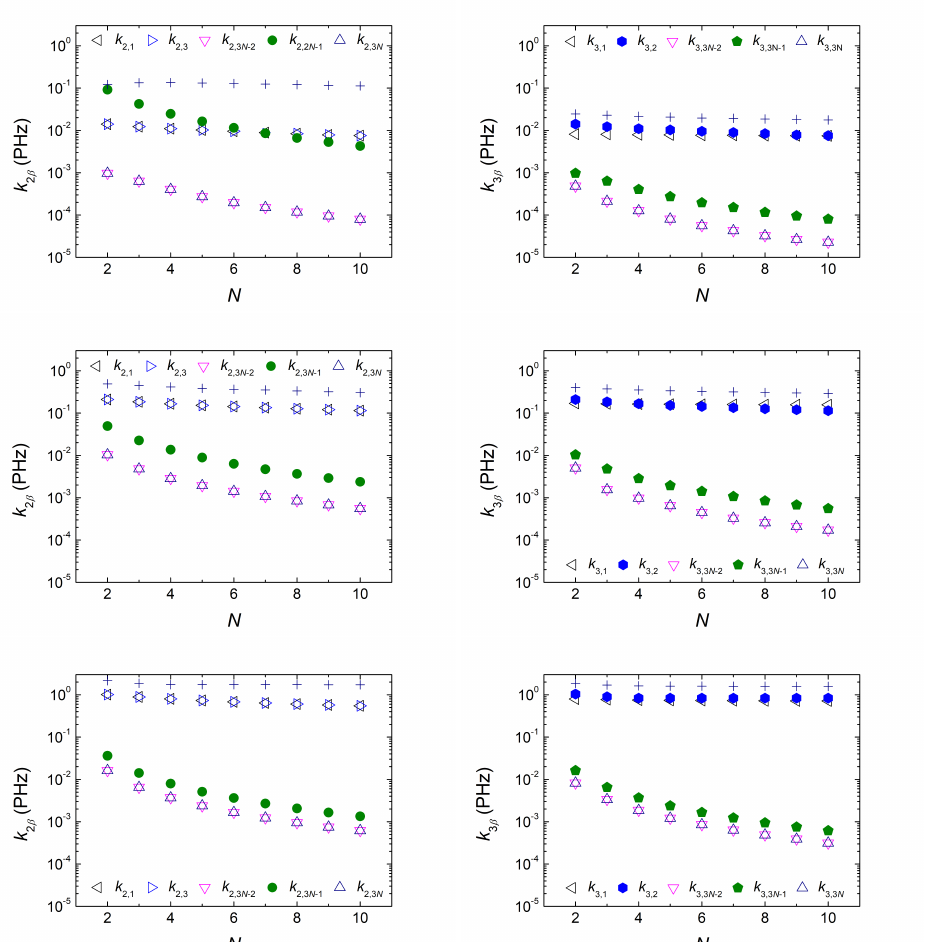
Figure 8. The mean transfer rates, k αβ ( k α , β ), from site α to sites β = 1, 2 (or 3), 3 N − 2, 3 N − 1, and 3 N , increasing the number of monomers in the polymer, N , for a G.. homopolymer. Left : α = 2. Right : α = 3. First, second, and third row corresponds to t S = 0.1, 0.5, and 2 eV, respectively. ∑ 3 N also shown ( +